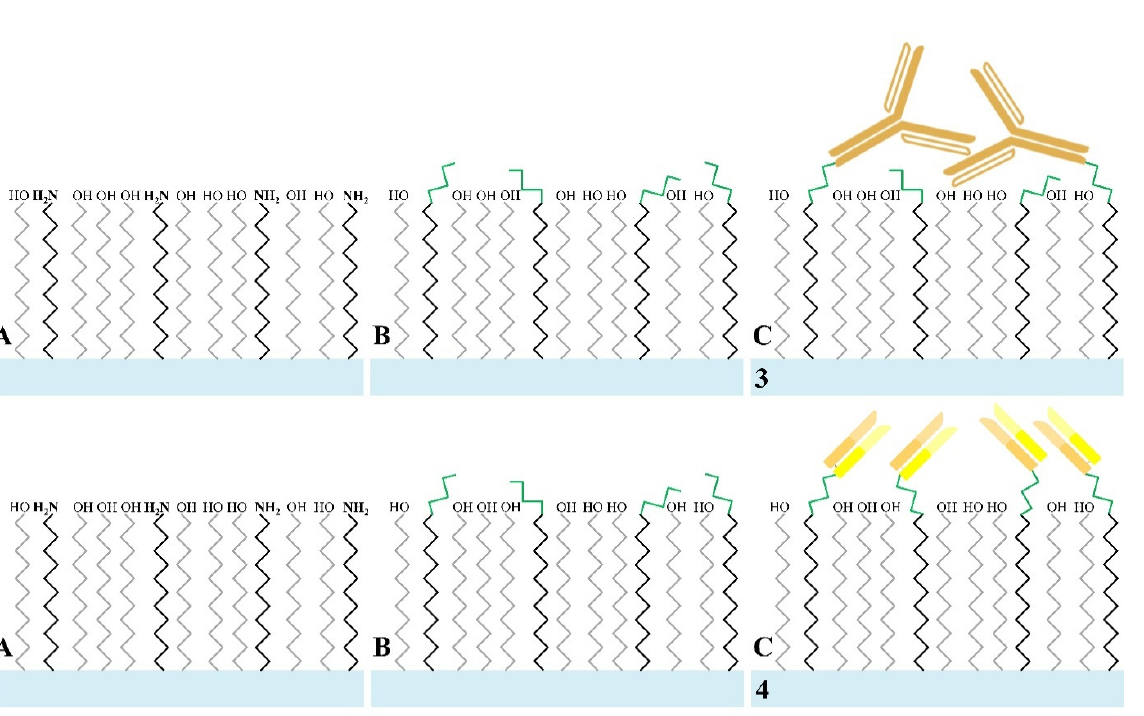
Figure 2. Depiction of the fabrication of Wab/PEG-SiNWFET (sample 3) and Fab/PEG-SiNWFET (sample 4) immunosensors in this study. ( A ) The SiNW channels (light blue bar) were modified with PEG-mSAMs (silane-PEG-NH 2 : black long zigzag shapes, silane-PEG-OH: grey long zigzag shapes) and ( B ) GA (green zigzag shapes) before ( C ) either the Wab (bronze Y shapes in sample 3) or the Fab (yellow-bronze bars in sample 4) were immobilized.